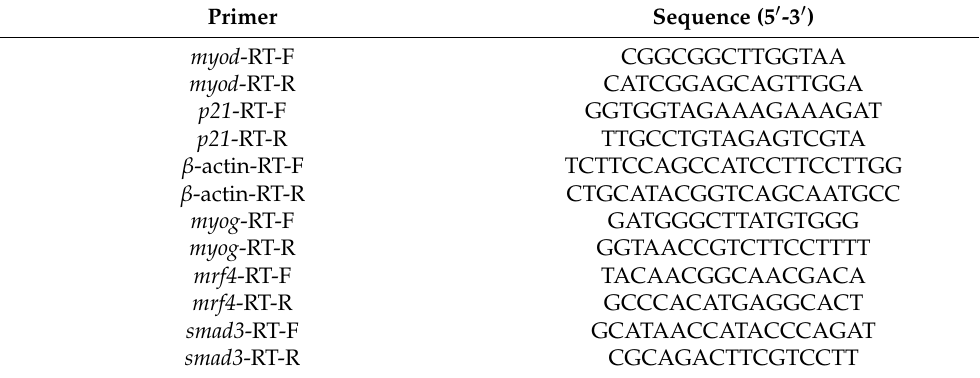
Table 2. Primers used in this